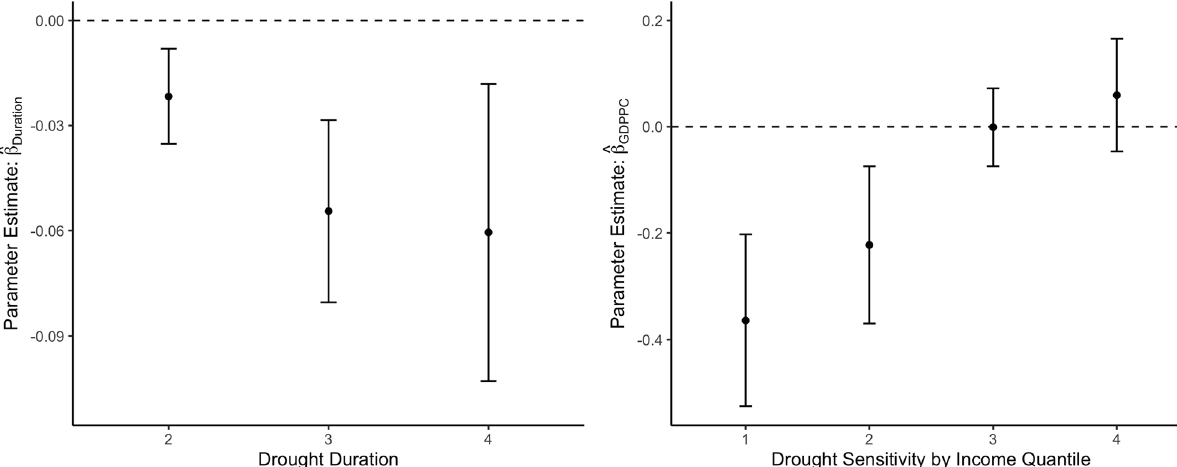
Fig. 3 | Non-monotonic effects of drought by severity (left) and income quantiles (right). The parameter estimates shown correspond to the mean effect ± twice its standard deviation for the regression model including cell fi xed effects, time fi xed effects and HAC standard errors. n